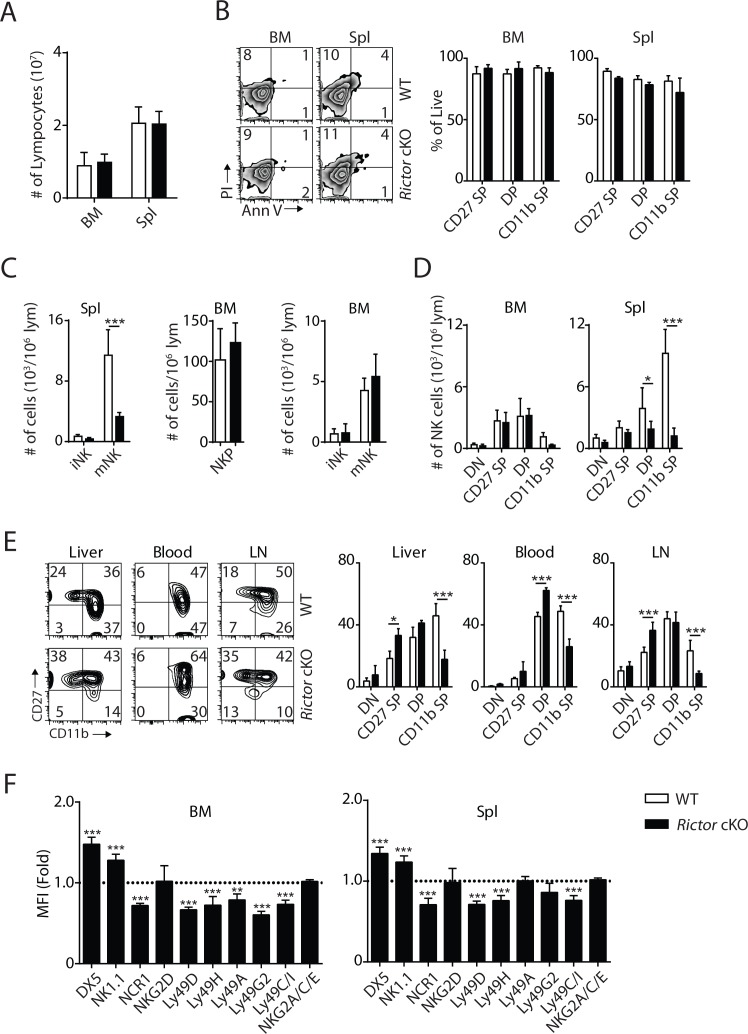
Terminal NK cell maturation was impaired in Rictor cKO mice.(A) BM and spleen lymphocytes count in WT and Rictor cKO mice. n = 4 pooled from two independent experiments. (B) The viability of freshly isolated NK cells from BM and spleen of WT and Rictor cKO mice was evaluated by Annexin V (Ann V) and Propidium iodide (PI) staining (left). Percentage of live cells (Ann V−PI−) in each population gated by CD27 and CD11b was quantified (right). n = 3 pooled from three independent experiments. (C) Number of iNKs (CD3−CD122+NK1.1+DX5−), mNKs (CD3−CD122+NK1.1+DX5+) in the spleen and NKPs (CD3−Flt3−CD27+2B4+CD127+CD122+NK1.1−), iNKs, mNKs in the BM from Rictor cKO mice were quantified using flow cytometry. n = 3–4 pooled from two or four independent experiments. (D) Number of each NK cell population defined by CD27 and CD11b expression in BM and spleen of WT and Rictor cKO mice was quantified as the number of cells per million lymphocytes. n = 6 pooled from four independent experiments. (E) CD27 and the CD11b expression on NK cells from liver, blood and lymph node (LN) of WT and Rictor cKO mice were assessed by flow cytometry (left). Percentage of each NK subsets was quantified (right). n = 3–4 pooled from two or three independent experiments. (F) Expression of various maturation markers on NK cells was shown as fold change in MFI normalized to WT. n = 4 pooled from two independent experiments. All bar graphs present the mean ± SD. Statistical significance was calculated using two-way ANOVA. *p<0.05; **p<0.01; ***p<0.001.